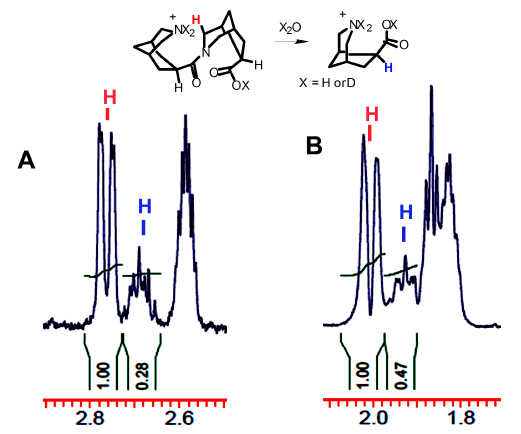
Figure 9. Characteristic regions of the 1 H-NMR spectra illustrating the hydrolysis rates of 2 · HCl in D 2 O ( A ) and H 2 O ( B ). After twelve days of reaction.